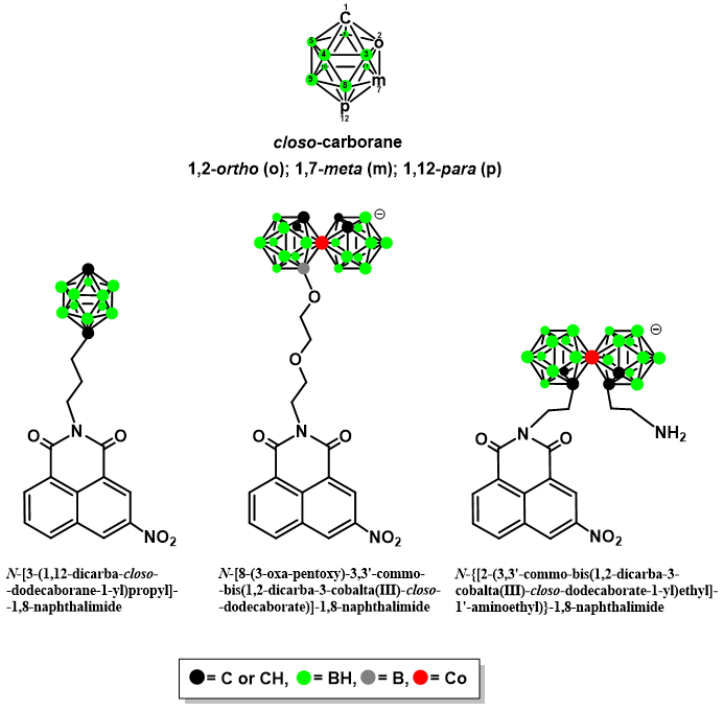
Figure 1. General structure of icosahedral dicarba- closo -dodecaborane ( closo -carborane, C 2 B 10 H 12 ), and example structures of naphthalimides with boron cluster [20].